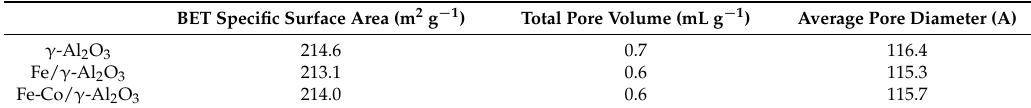
Table 2. BET test results of γ -Al 2 O 3 Fe/ γ -Al 2 O 3 and Fe-Co/ γ -Al 2 O 3 particles.